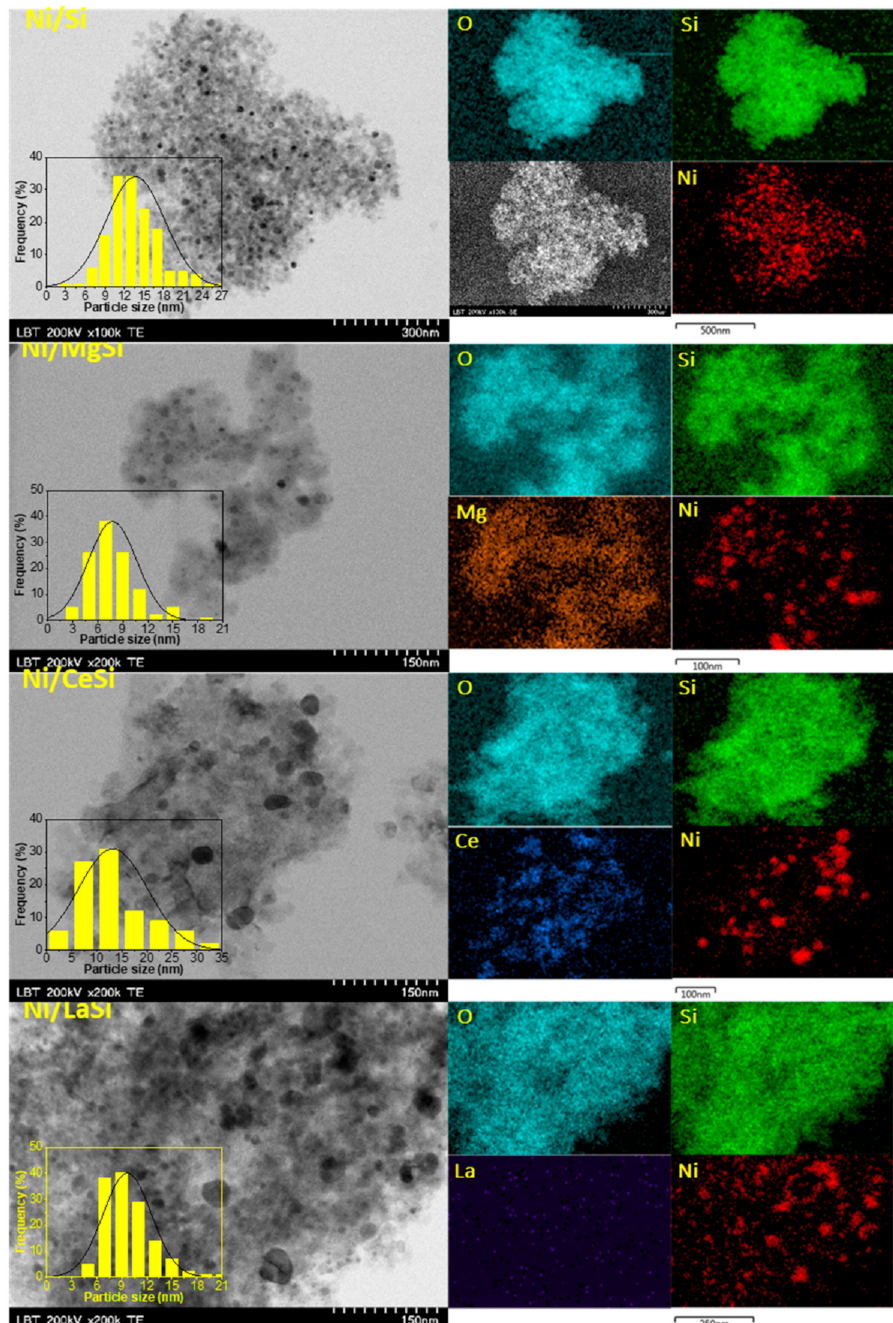
Figure 3. TEM images and EDX mapping of silica supported Ni